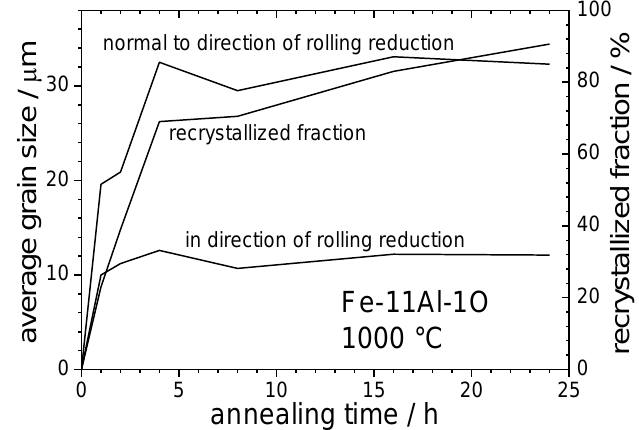
Figure 3. Evolution of the grain size normal and parallel to the rolling reduction and fraction of recrystallized area in the Fe-11Al-1O system during annealing at 1000 °C.